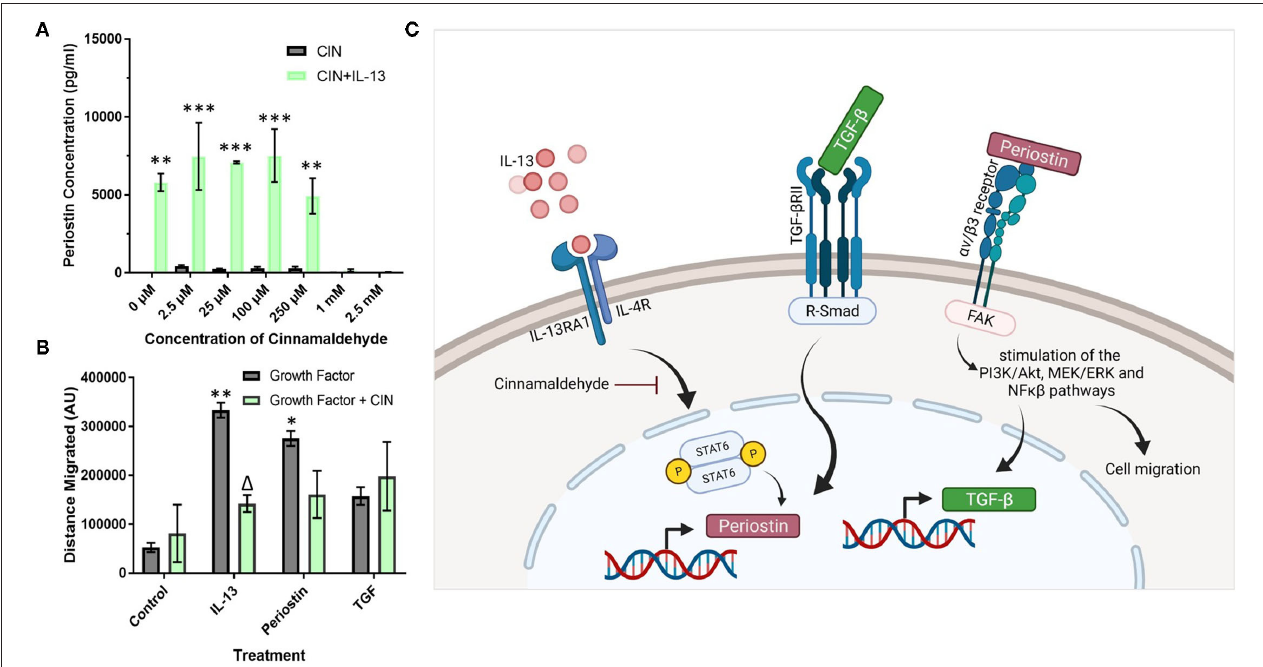
FIGURE 4 | Cinnamaldehyde treatment suppresses periostin expression and pericyte migration. (A) Cultured pericytes were treated with 100ng/ml IL-13 in pericyte media for 7 days with the addition of cinnamaldehyde for the last 3 days at the concentration stated in (A) or only cinnamaldehyde at the stated concentration for 3 days. The supernatants were harvested and the periostin content was assessed by ELISA. ** p < 0.01, *** p < 0.001 vs. the same cinnamaldehyde concentration without IL-13, n = 2 representative of two independent experiments. (B) Scratch assay performed on pericytes that were grown in pericyte medium and treated with 10ng/ml of TGF- β , 100ng/ml of IL-13 or 100ng/ml of periostin for 7 days with 1mM cinnamaldehyde added for the last 3 days. Cells were transferred into media lacking serum and a scratch was made in each monolayer using a p200 pipette tip. Images were taken at 100x magnification immediately after scratching and 24h later. The scratch width was determined using ImageJ and the average distance of cell migration was calculated. n = 3 representative of two independent experiments, 1 = p < 0.05 vs. the same growth factor treatment without cinnamaldehyde, * p < 0.05, ** p < 0.01 vs. control treatment without cinnamaldehyde. (C) Schematic diagram of the putative signaling pathways regulating periostin expression in pericytes (created using